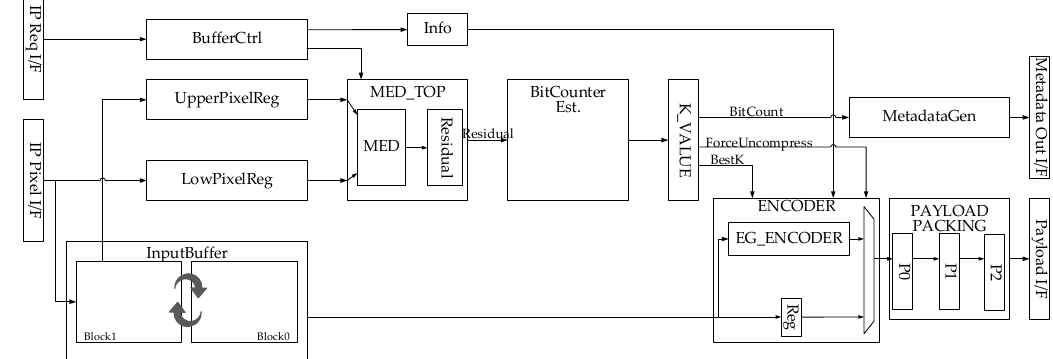
Figure 8. Proposed LEC compression engine.